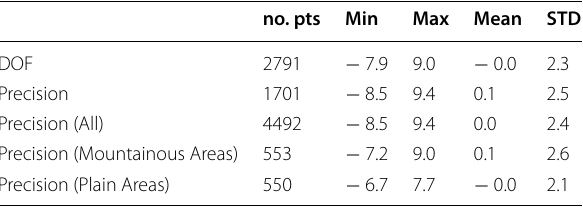
Table 2 Geoidal height differences between KNGeoid18 and GNSS/Leveling data (unit: